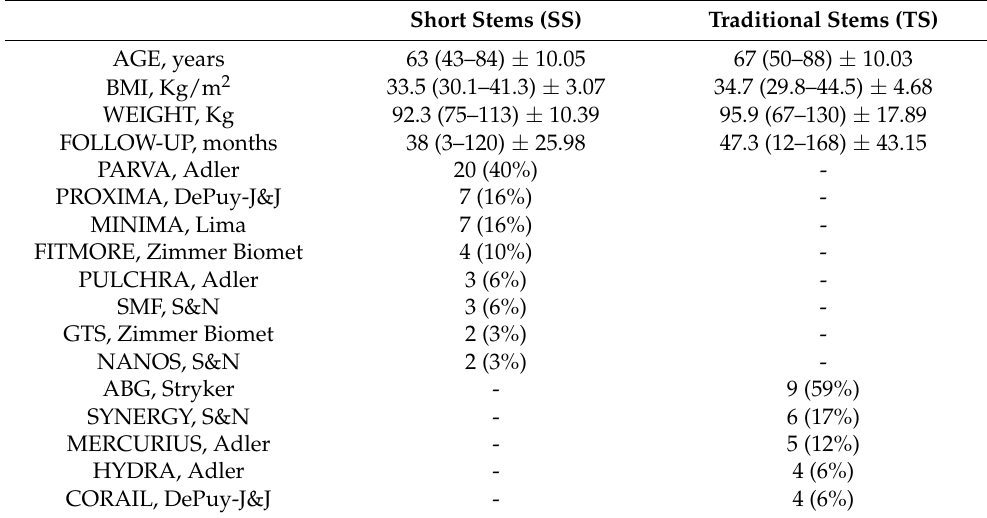
Table 1. Demographics of our sample and implanted devices. The case study group includes 48 patients undergoing THA with short stems. The control group includes 28 patients who underwent THA with standard traditional